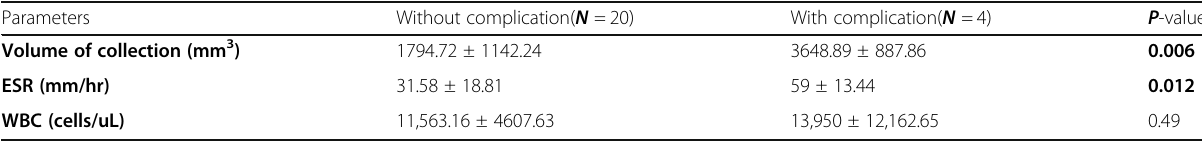
Table 6 Compression of volume of collection, ESR, and WBC in patients with and without complication